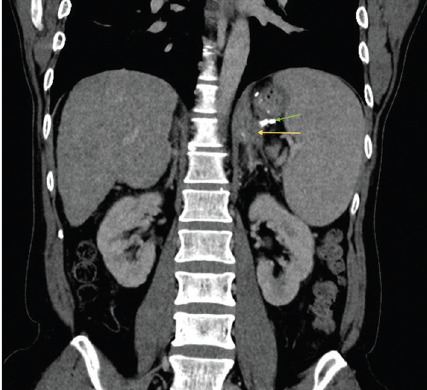
Figure 5: Computed tomography view of the abdomen (in coronal view) after completion of antibiotics. The previously seen retro- gastric abscess has completely resolved leaving behind a small area of scarred tissue (yellow arrow). The residual N-butyl-2-cyano- acrylate in the perigastric region is still visible (green arrow).